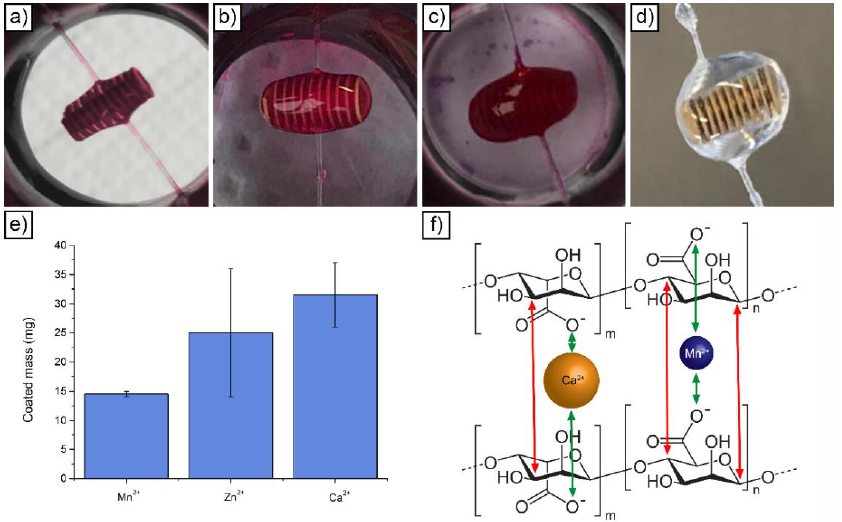
Figure 3. Visual appearance of devices coated with Ca-reticulated hydrogel after one ( a ), two ( b ), three ( c ) and four ( d ) coating cycles; amount of applied hydrogel after a single coating cycle as a function of the physical crosslinker employed ( e ); schematic representation of two alginate chain crosslinked with either Ca or Mn ( f ).